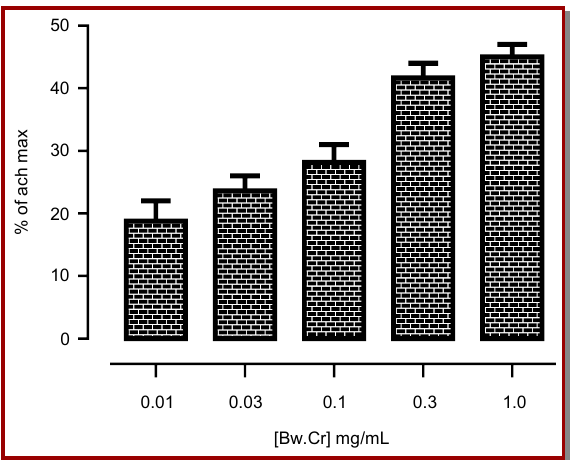
Figure 3 : Concentration-dependent inhibitory effect of the crude extract of B. wallichiana and verapamil against K + (80 mM)-induced contractions in isolated rabbit jejunum prepara- tions (values are expressed as mean ± SEM, n =